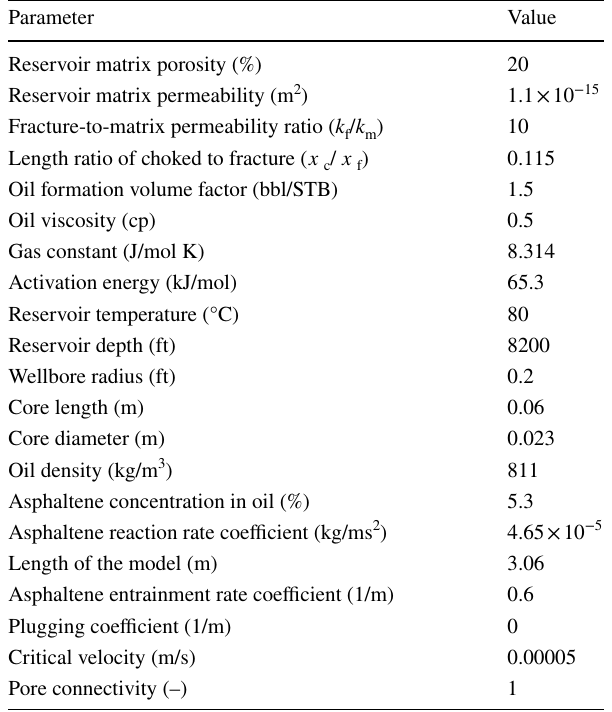
Table 1 Summary of the input parameters of the model used for asphaltene deposition and fracture